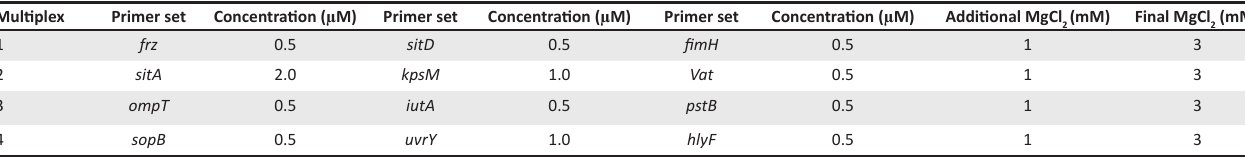
TABLE 1: Final primer concentrations used in the different multiplex polymerase chain reactions. Multiplex Primer